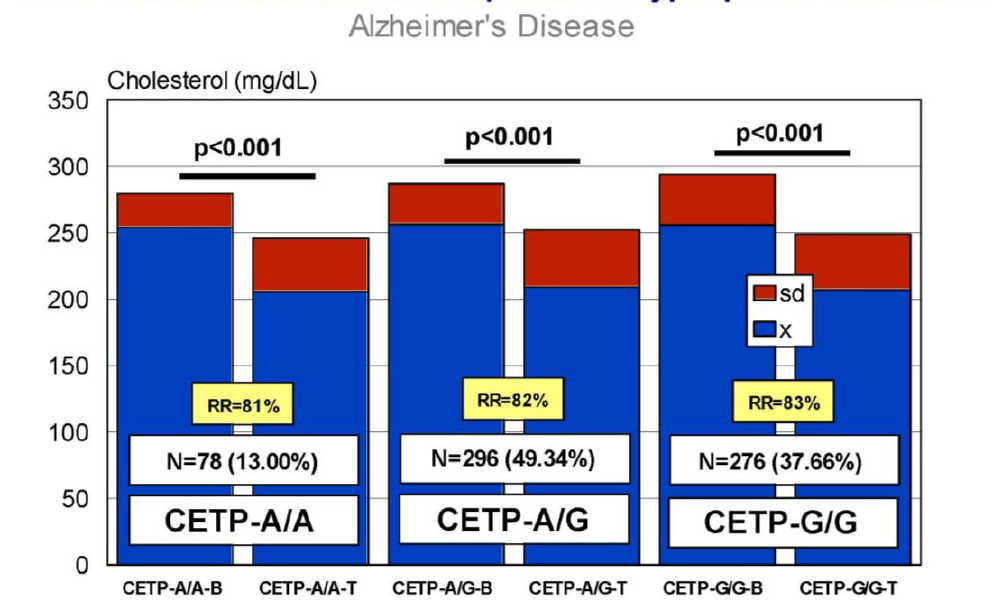
Figure 11. CETP -related cholesterol response to a hypolipemic treatment in hypercholesterolemic patients with Alzheimer’s disease (Atorvastatin: 10–20 mg/day; LipoEsar: 500 mg/day).